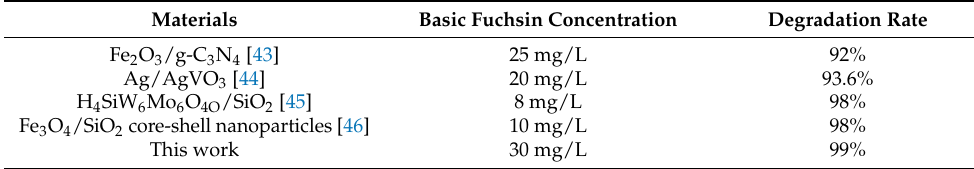
Table 3. ZIF-8(Eu)@Mc-TiO 2 -specific surface area and pore size